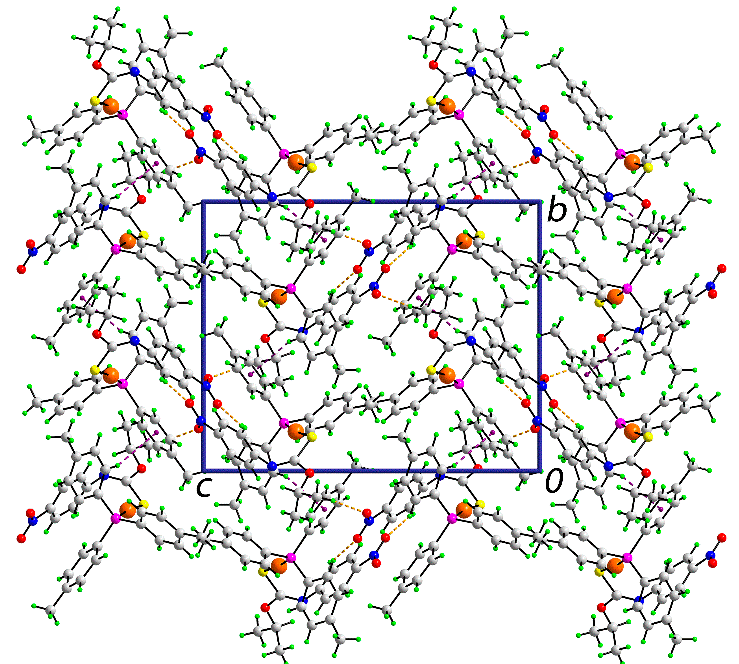
Figure 2. Molecular packing in the crystal of 1 : a view of the unit cell contents in projection down the a -axis. The C ‒ H … O and C ‒ H … π interactions are shown as orange and purple dashed lines, respectively.